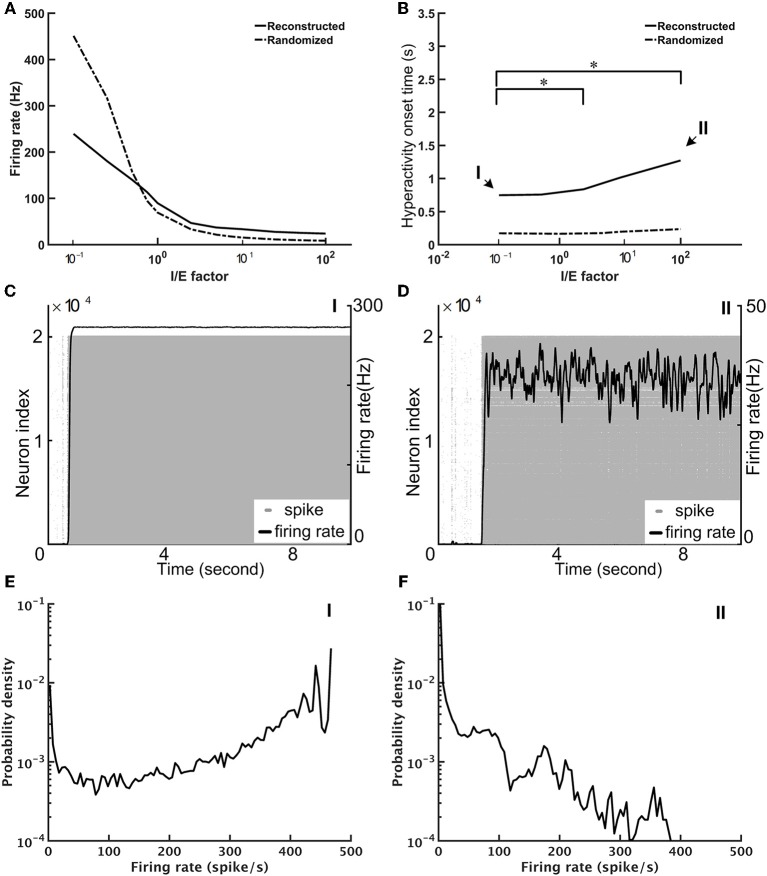
The seizure-like hyperactivity can be reduced but not completely eliminated by stronger weights for the inhibitory synapses, as represented by the I/E factor (A) The mean firing rate as a function of the I/E factor for the reconstructed fruit fly brain and a randomized fruit fly brain. (B) The mean onset time of the seizure-like activity as a function of the I/E factor. Larger I/E factors significantly delay the onset time for the reconstructed fruit fly brain, but not for the randomized fruit fly brain. Furthermore, the reconstructed fruit fly brain is more stable than the randomized brain as indicated by the larger onset time for all I/E factors. Asterisks indicate the statistical significance (Student-t test, p < 0.05) in the change of mean onset time between different I/E factor conditions for the reconstructed brain. (C,D) The spike rastergrams (gray dots) and the firing rates (black curves) of the reconstructed fruit fly brain at the low (0.1, point I in B), and high (100, point II in B) I/E factors, respectively. (E,F) The distributions of single neuron firing rates of the reconstructed fruit fly brain with the same I/E ratio as in (C,D), respectively.